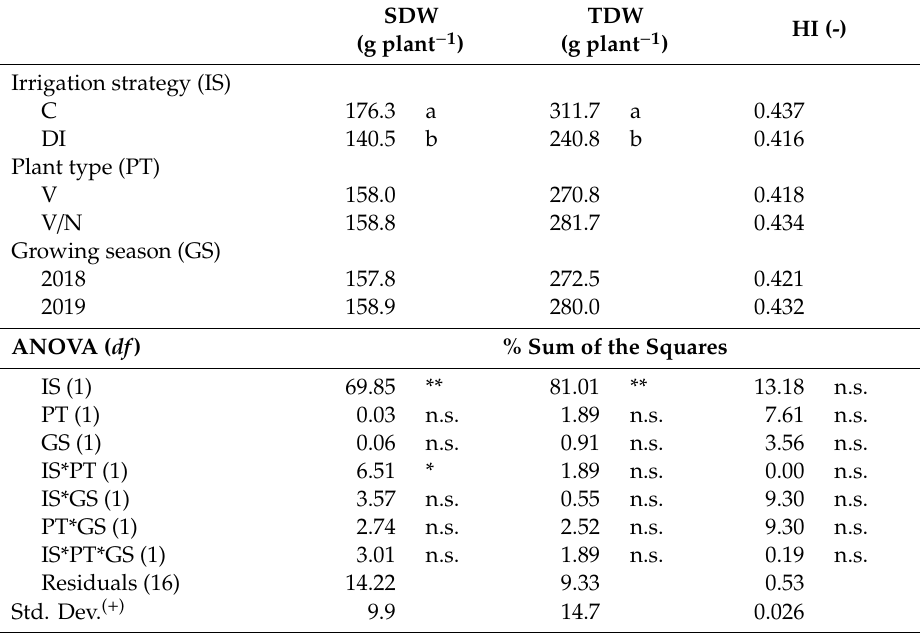
Table 3. E ff ect of irrigation strategy, plant type, and growing season on the shoot dry weight (SDW), total dry weight (TDW), and harvest index (HI).